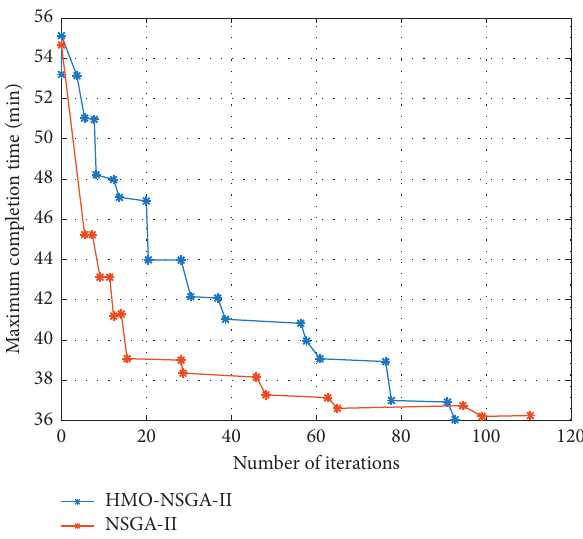
Figure 2: Comparison between HMO-NSGA-II and NSGA-II for solving MK01